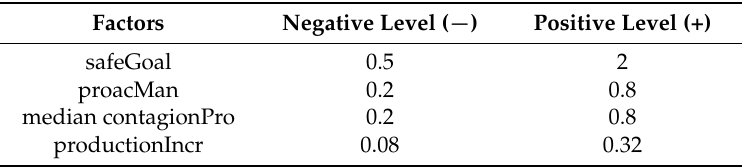
Table 4. The negative and positive levels for the four-factor experiments.